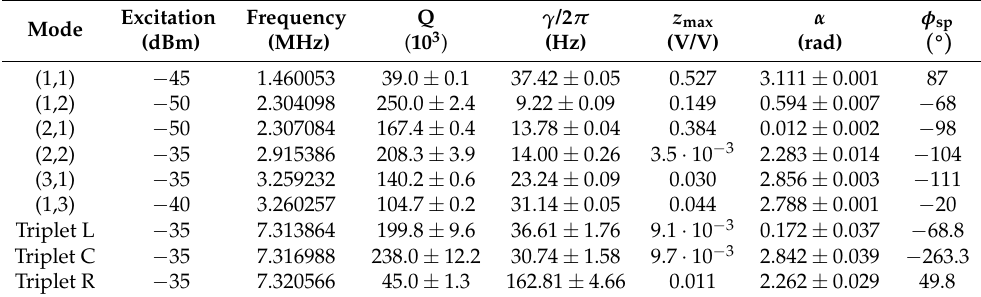
Figure A1. Network analyzer measurement of the driven response near the (3,1) and (1,3) eigenfre- quencies. Two separate resonances with a spacing of 1.06 kHz can be seen. As discussed in the text, the left and right resonance corresponds to the (3,1) and (1,3) mode, respectively Table A1. Overview of the excitation power, setpoint, and fit parameters (see Figure A2) for the modes used in the main text. The fit uncertainty in the resonance frequency is below 3 Hz for all modes, but the exact value drifts over the course of